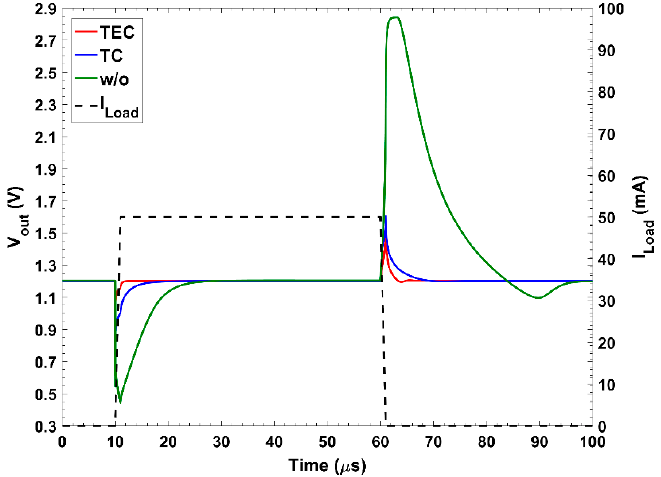
Figure 7. Impact of the transient enhancement circuits on the load transient behavior (at V BAT 3.3 V).